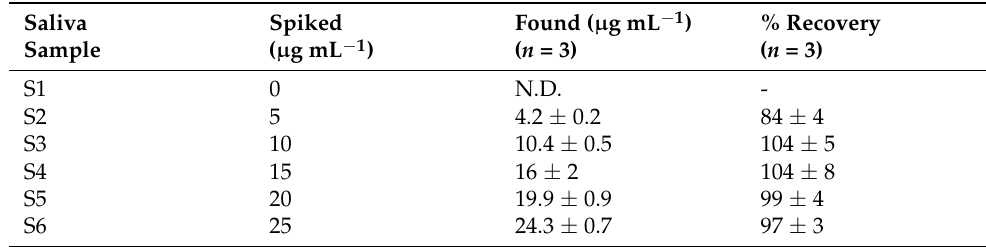
Table 2. Determination of MA concentrations in saliva sample using the proposed LI-PGr electrode coupled with a developed portable device with the recovery values of MA from saliva sample.